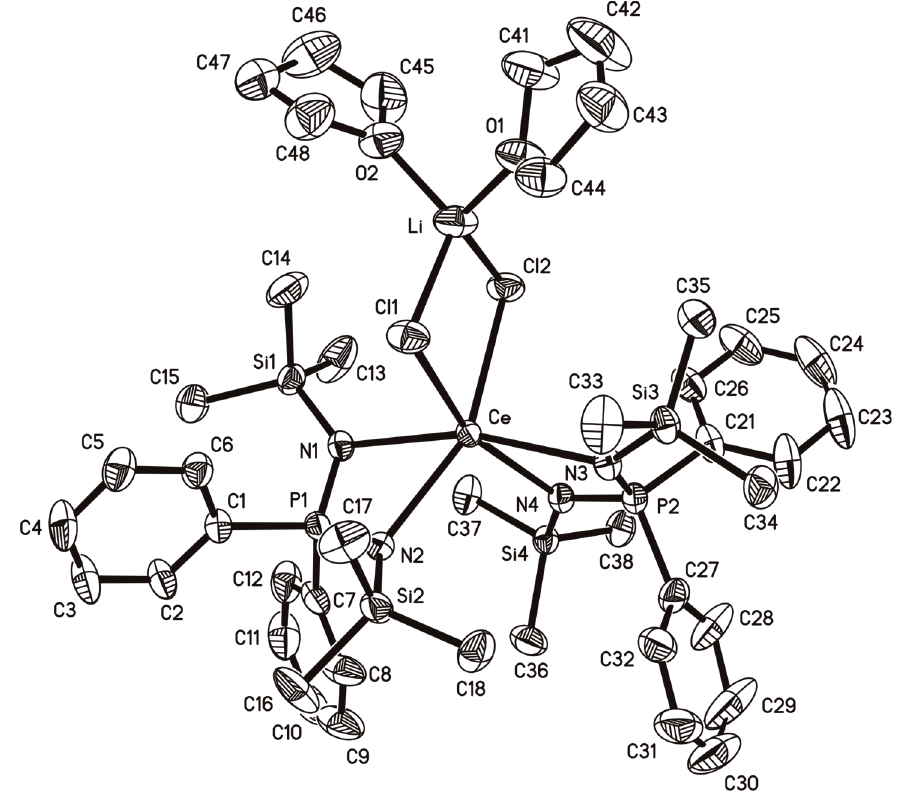
Figure 5. Molecular structure of 9 in the crystal, showing the atom-labeling